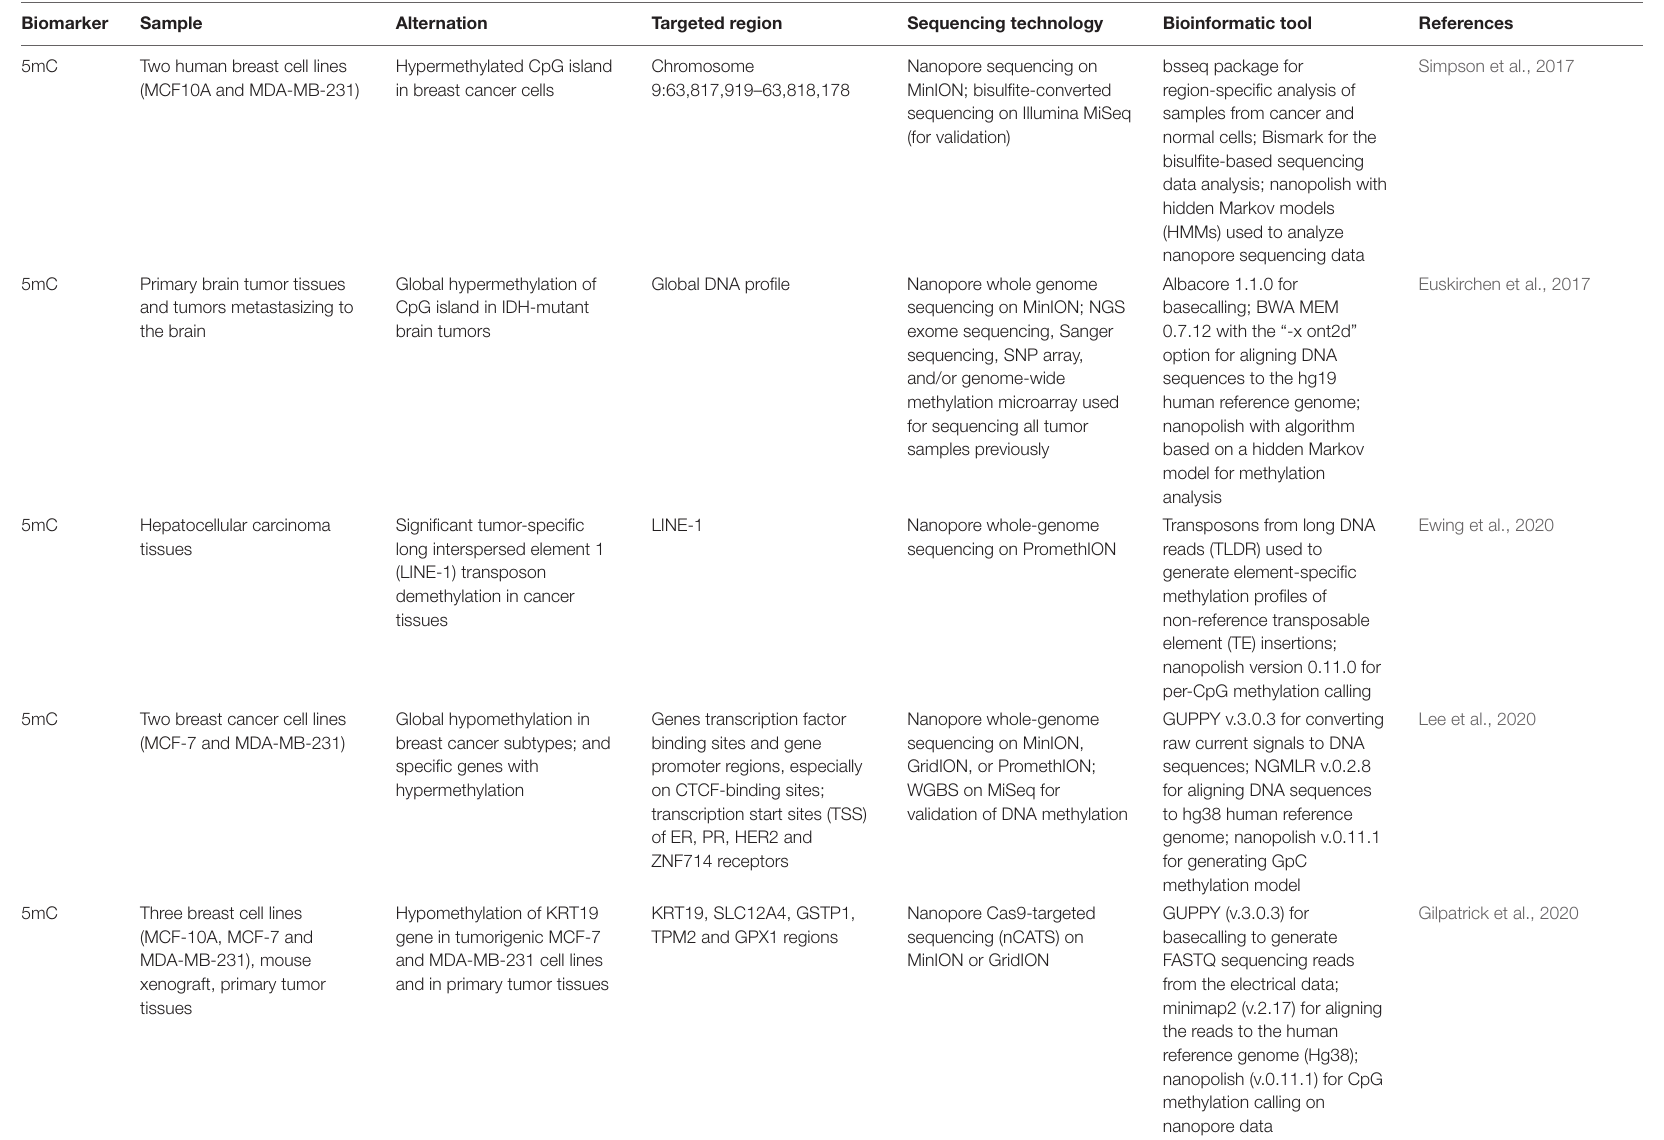
TABLE 1 | Detection of methylation modification by nanopore sequencing.